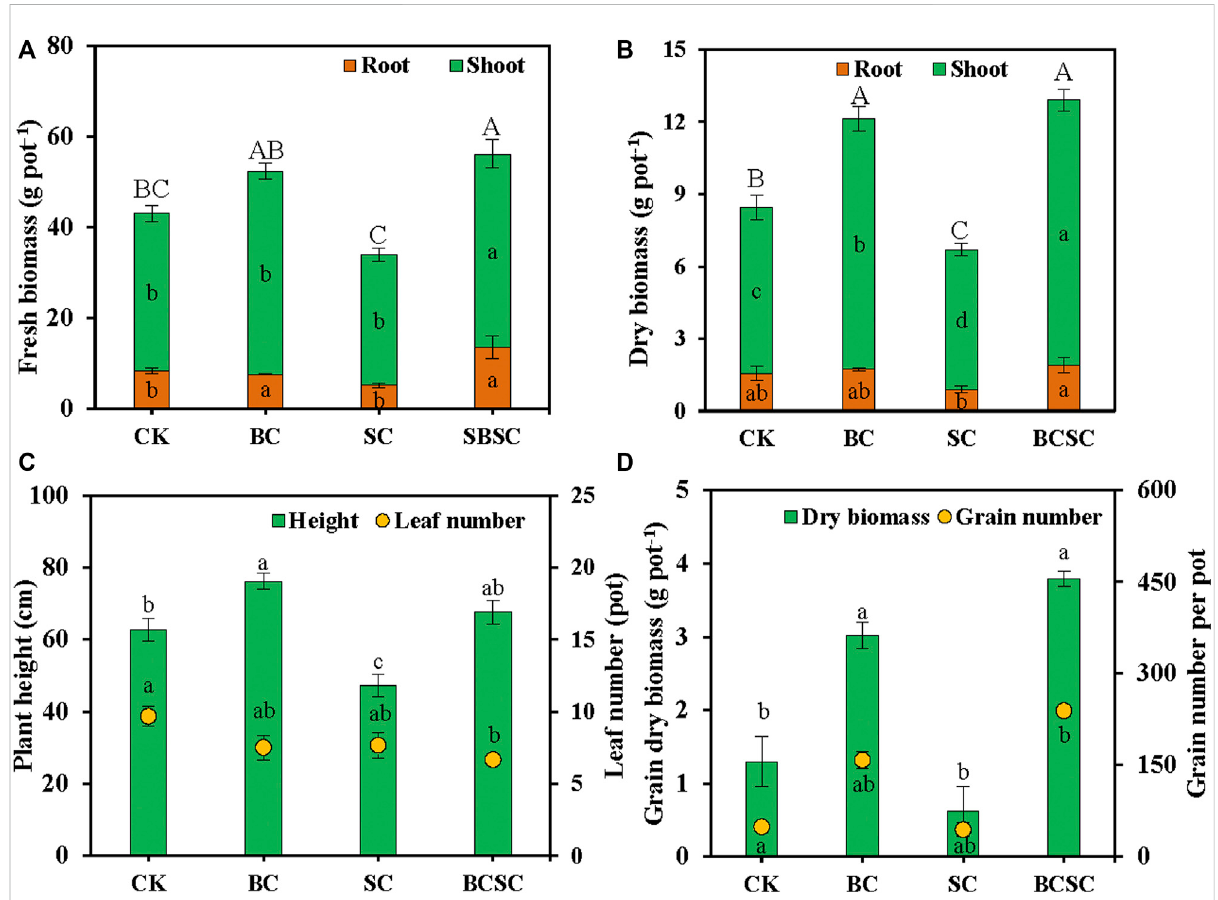
FIGURE 2 Effect of biochar, compost, and biochar-compost addition on sorghum growth and yield in coastal soil. (A) Sorghum fresh biomass, (B) sorghum dry biomass; (C) sorghum height, and (D) sorghum grain dry biomass and grain number. CK: soil without amendment; BC: soil amended with corn straw biochar at 1.0% (w/w); SC: soil amended with seaweed compost at 1.0% (w/w); and BCSC: soil amended with cocomposted biochar and seaweed at 1.0% (w/w). The error bars represent the standard error of the mean ( n = 3). Different small letters indicate the signi fi